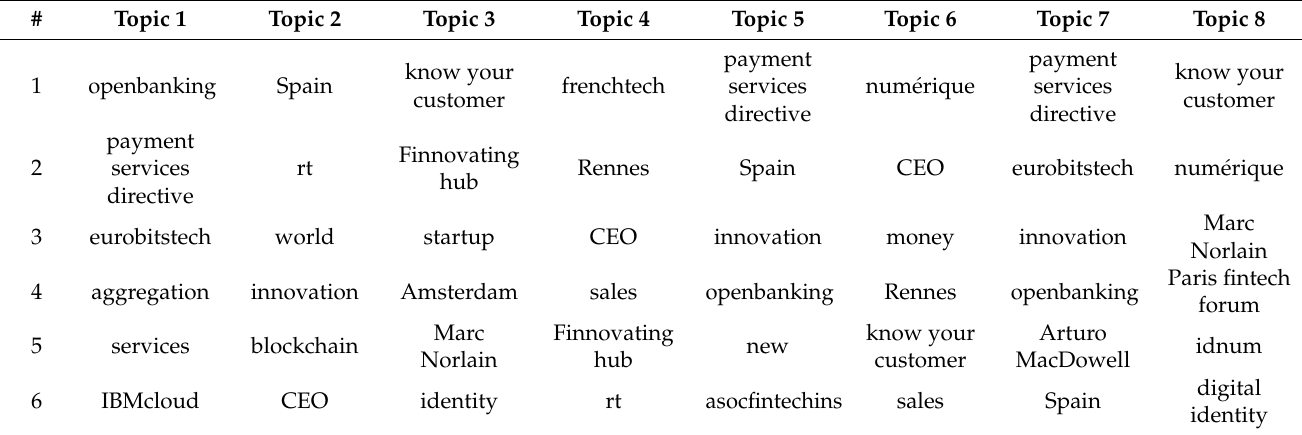
Table 4. Topic modeling results of the financial infrastructure field.